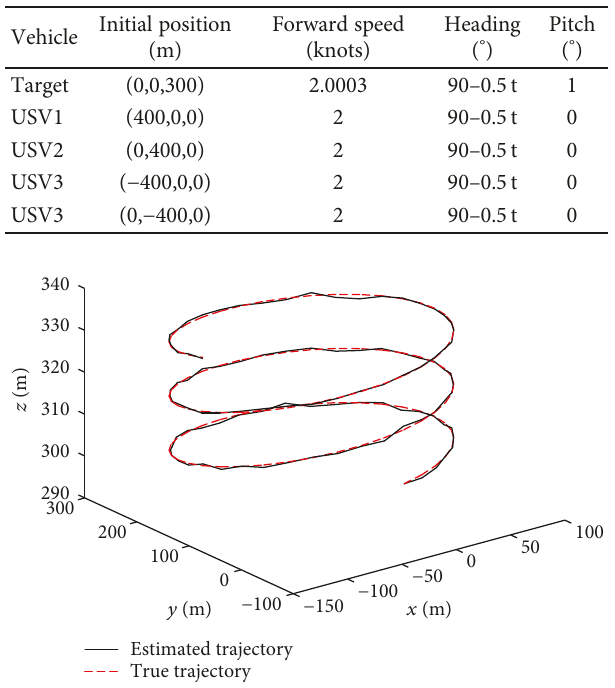
Figure 3: True and estimated trajectories of the target in optimal